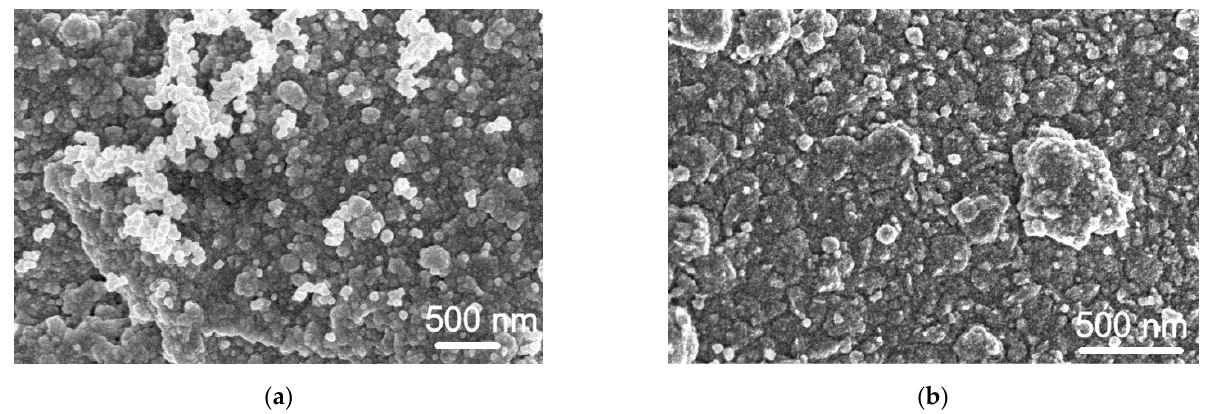
Figure 8. SEM images of the roughed glass sheet after the electroless Pt plating using the Co 3+ /Co 2+ redox couple ( a ) and hydrazine ( b ) as reducing agents.